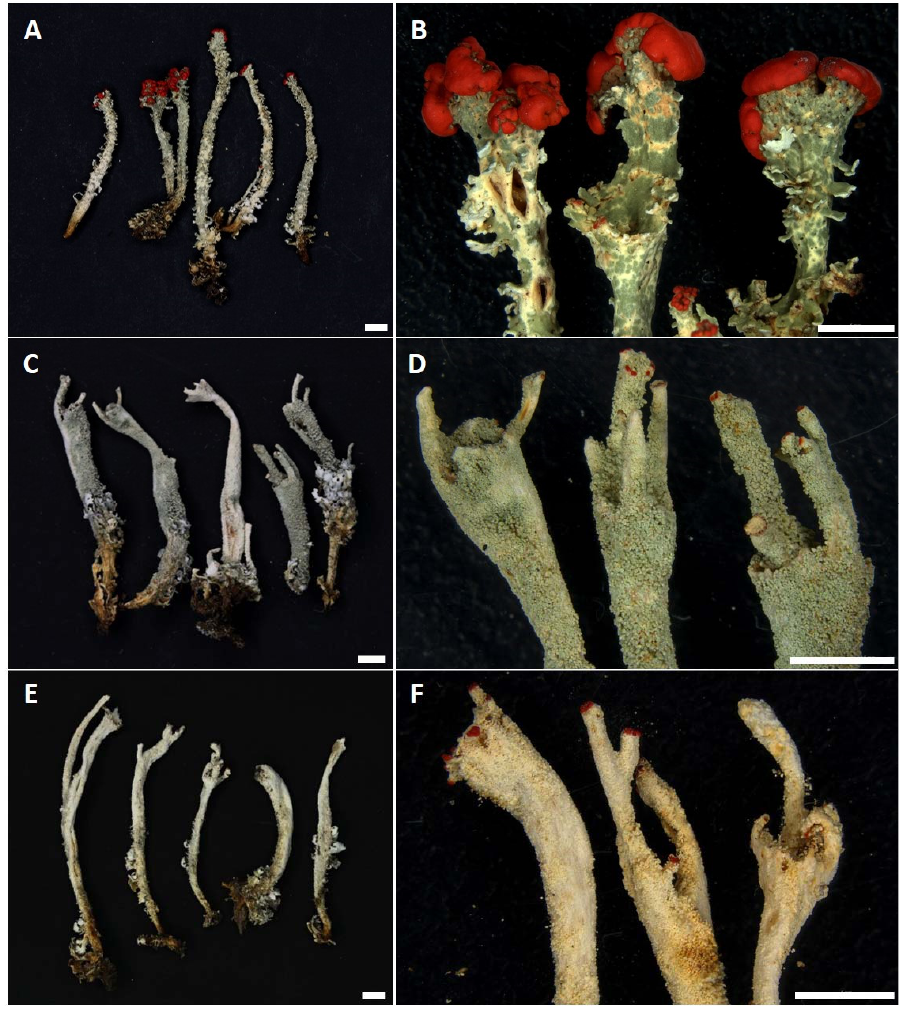
Figure 1. Morphology of the Cladonia species studied. ( A , B ) = Cladonia bellidiflora (J13); ( C , D ) =